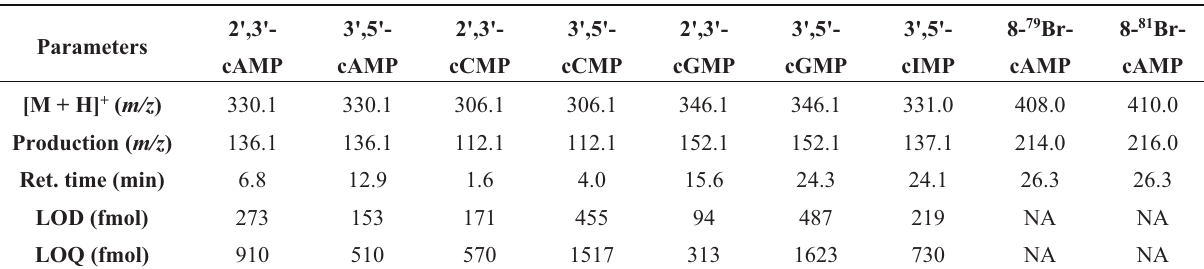
Table 1. Mass spectrometric parameters for the measured transitions of cyclic nucleotide monophosphates (cNMPs) and internal standard (8-Br-cAMP;